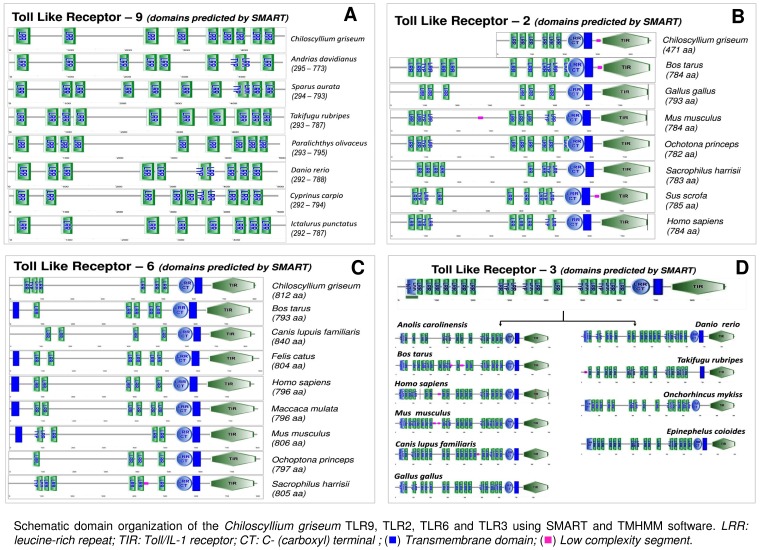
Schematic diagram of the domain organization of the Chiloscyllium griseum TLR type transcripts - TLR9, TLR2 TLR6 and TLR3 predicted using the SMART software.
A– TLR9 domain structure; B- TLR2 domain structure; C – TLR6 domain structure and D- TLR3 domain structure. LRR- luecine rich repeat; TIR – Toll/IL-1 receptor. The domain structure of these TLR types almost remained similar to the higher vertebrate TLRs.